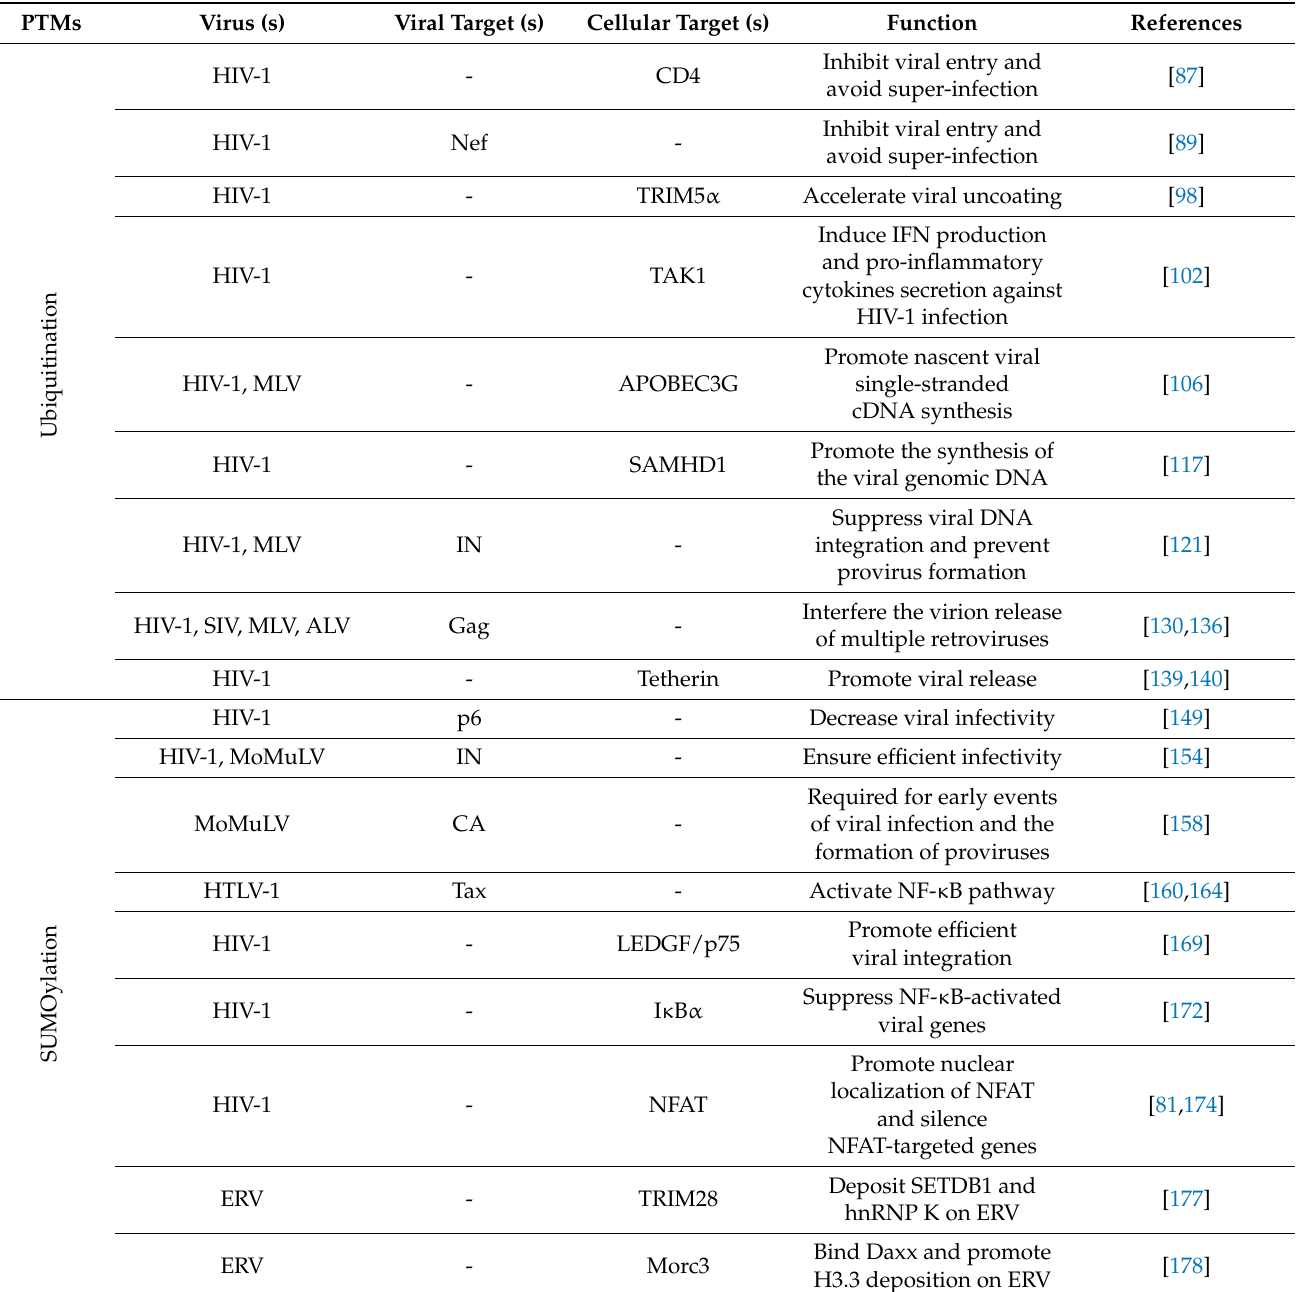
Table 1. Involvement of ubiquitination and SUMOylation of viral targets or cellular targets in retroviruses infection. The major function of PTMs of targets is also summarized. The order of these targets within the table is determined by the order that viral or cellular targets appear within the main